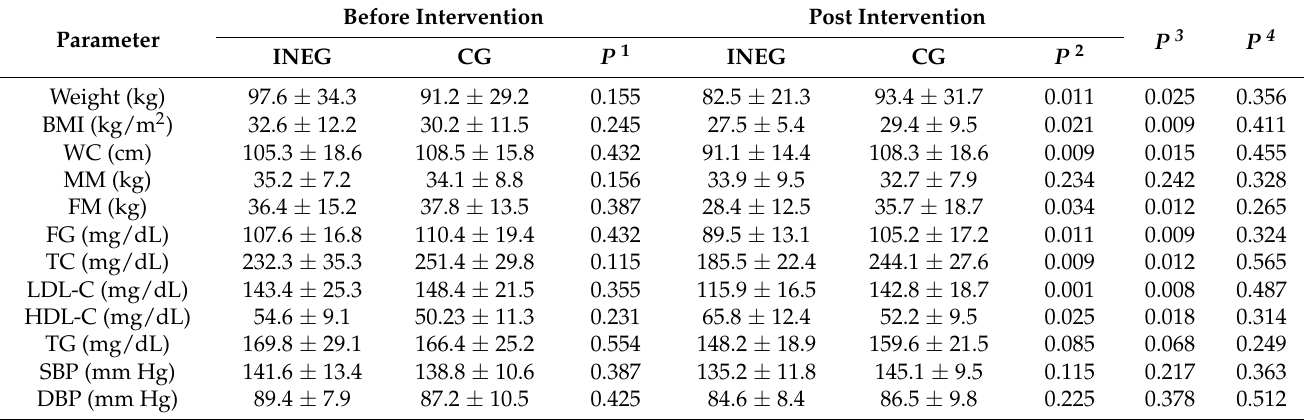
Table 4. Changes in metabolic outcomes at baseline and 3-months post-intervention.